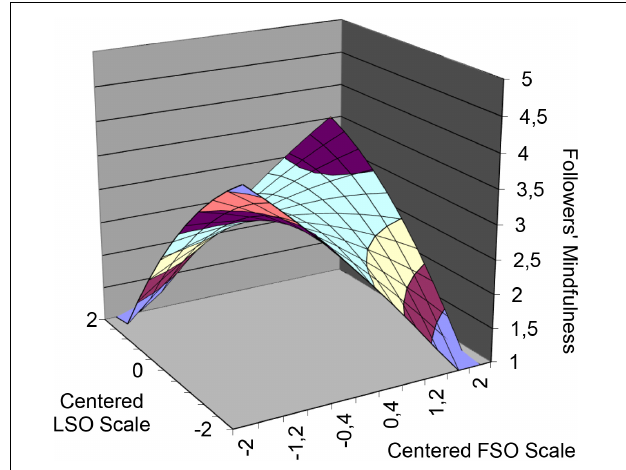
FIGURE 3 | Leader–follower strategic optimism (mis)match matrix predicting followers’ mindfulness. LSO = Leader’s strategic optimism; FSO = Follower’s strategic